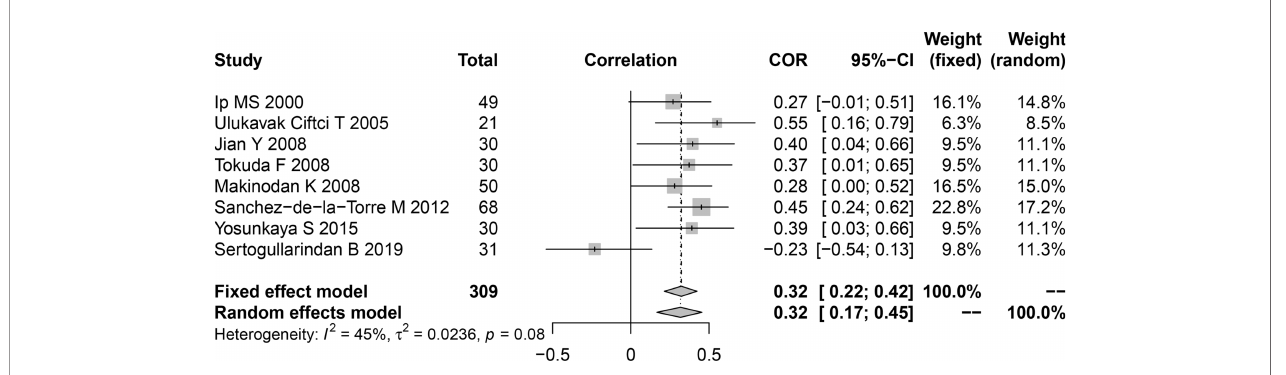
FIGURE 4 | Funnel plot of effect sizes measured as correlations between serum/plasma leptin levels and AHI. AHI, apnea-hypopnea